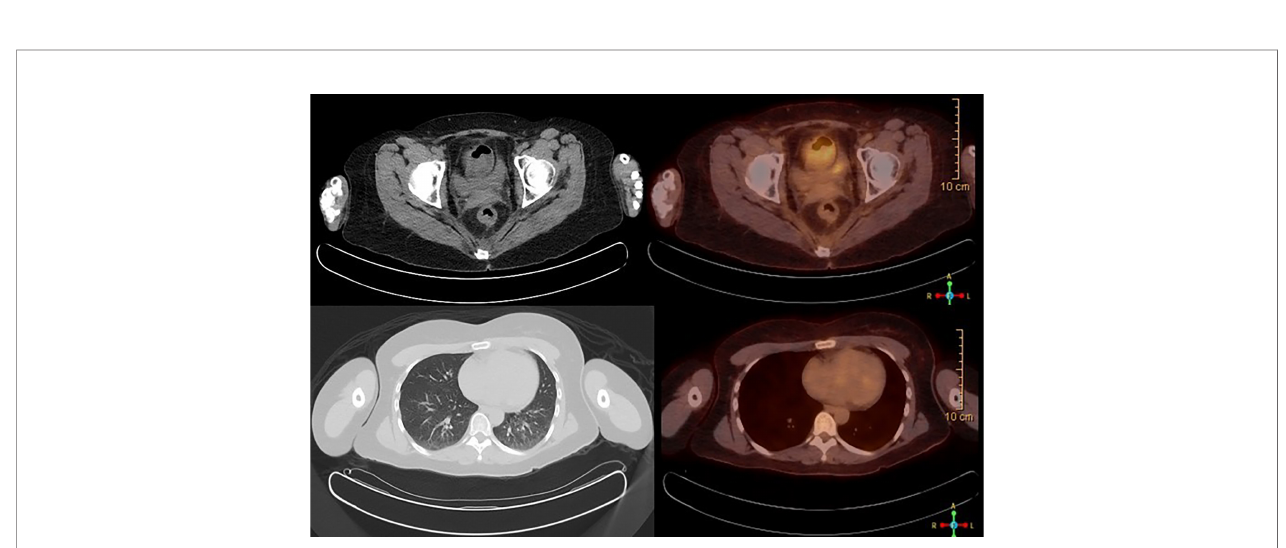
FIGURE 4 | CT chest/abdomen with contrast after starting pembrolizumab showing a decrease in the size of lung metastasis.